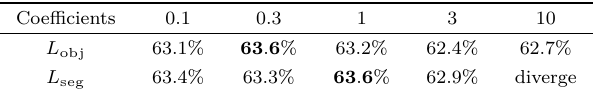
Table 3 Performance of S4Net evaluated by mAP 0 . 7 for different coefficients for L obj and L seg in the loss function, to determine the optimal settings and analyze sensitivity to these coefficients. “diverge” indicates the loss function fails to converge in training. Changing the coefficients has little impact Coefficients